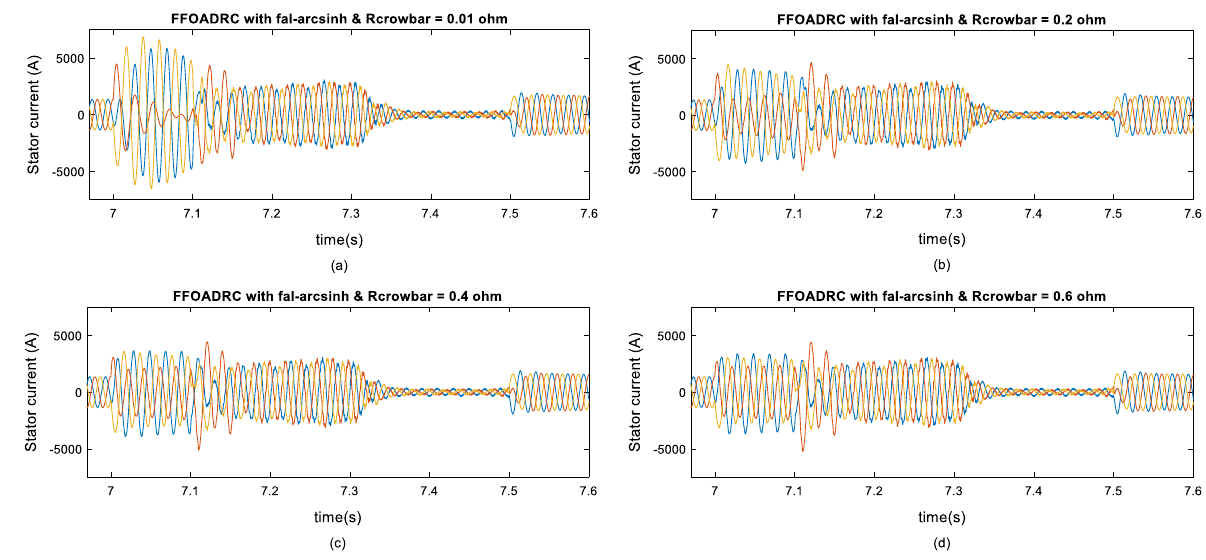
Fig. 34 Stator current of the DFIG during asymmetrical voltage sag for different values of R crowbar . ( a ) R crowbar R crowbar 0.4 ohm, and ( d ) R crowbar =